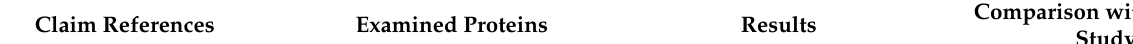
Table 1. Selection of Literature Claims Regarding Protein Structure vs.